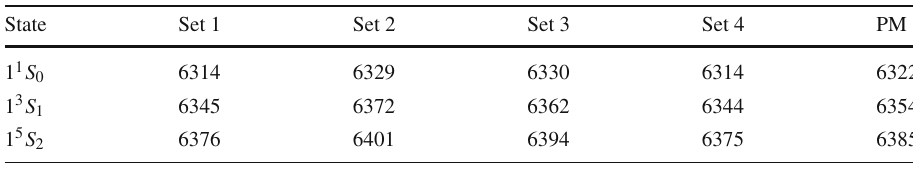
Table 15 Responses in bb ¯ b ¯ b tetraquark mass values to potential parameter input in group 2. PM stands for results of potential model used in this work. All results are in